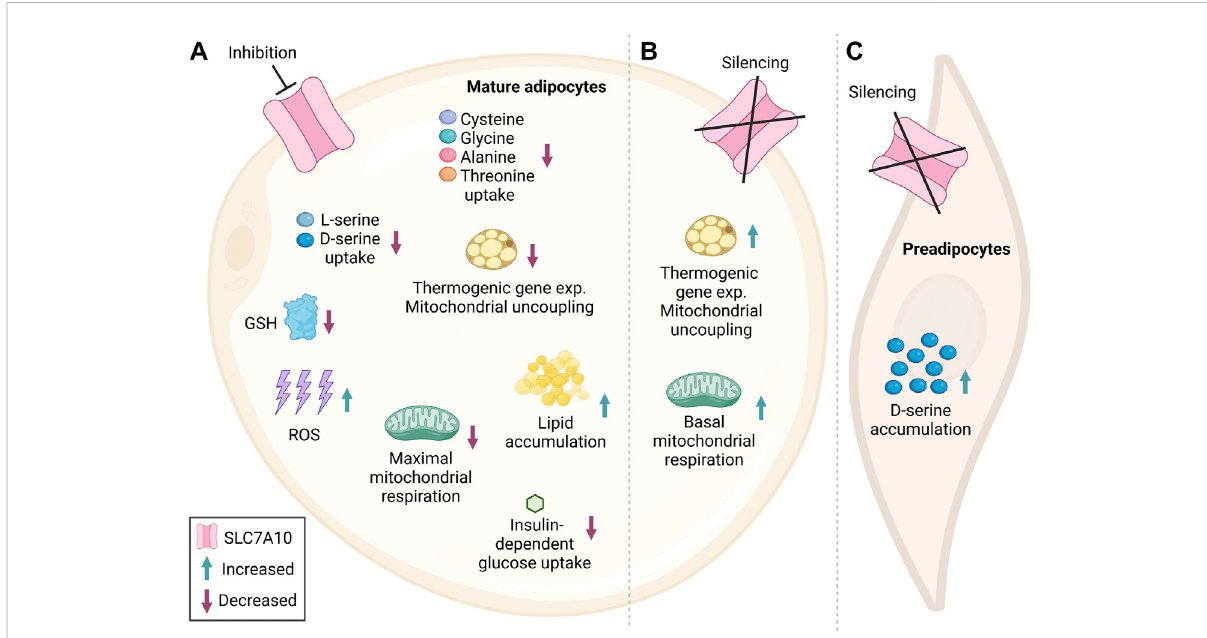
FIGURE 2 Simpli fi ed summary fi gure of the metabolic consequences of impaired SLC7A10 function in adipocytes. Several studies have implicated SLC7A10 as an important player in adipocyte metabolism. Blunted SLC7A10 in cultured human subcutaneous and mouse fat cells reduces serine uptake and the total level of the antioxidant glutathione, which may further have caused the observed increase in ROS generation (A) . Moreover, inhibition of the carrier has been found to reduce consumption of cysteine, glycine, alanine and threonine in adipocytes isolated from human deep neck adipose tissue (A) . Impairment of SLC7A10 also counteracted insulin-stimulated glucose uptake in cultured human subcutaneous and murine adipocytes (A) . Furthermore, the high ROS levels might, at least in part, promote the observed increase in lipid accumulation and associated reductioninmitochondrialrespirationseeninculturedhumansubcutaneousandmouseadipocytes,althoughthesequenceoftheseeventsneedto beestablishedinfurtherstudies (A)